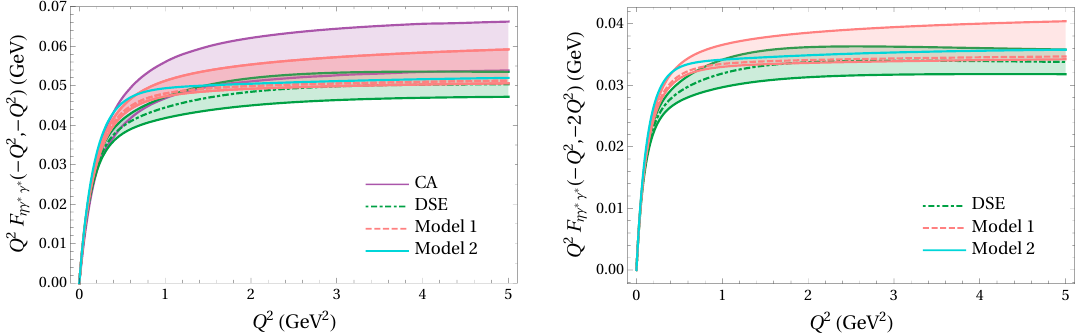
Figure 29. Doubly-virtual (cid:17) TFF in the symmetric region Q 2 where Q 2 = Q 2 and Q 2 = 2 Q 2 (right). Legend is the same as in (cid:12)gure 1 2